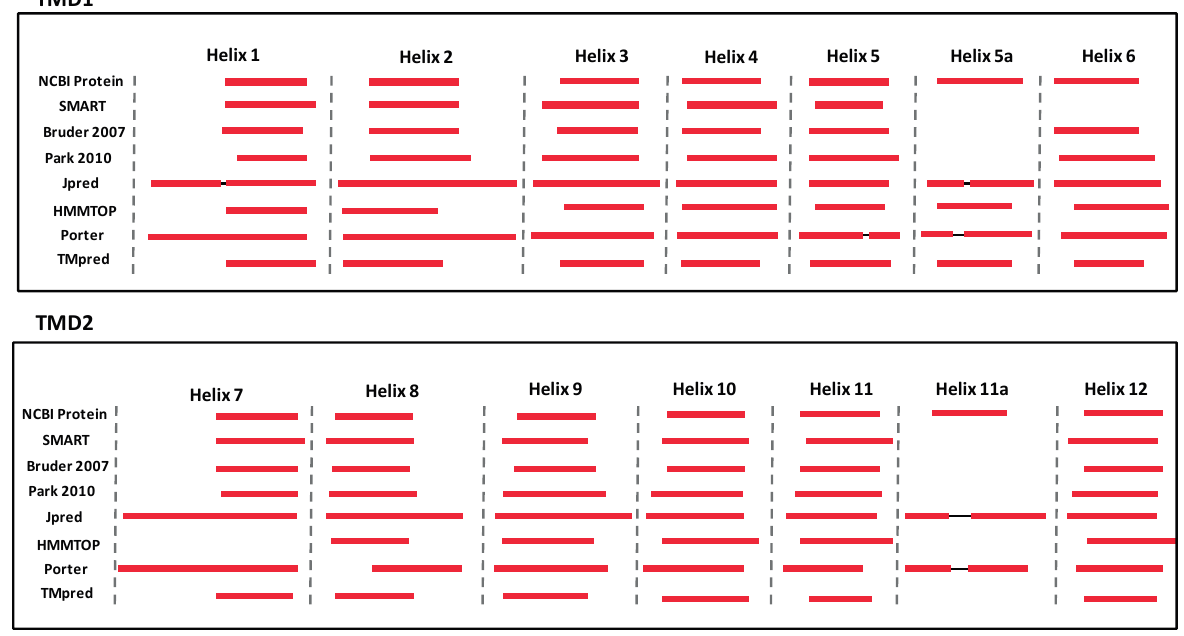
Figure 2. The α -helices of the TMD1 and TMD2 predicted by various bioinformatics software are indicated (red